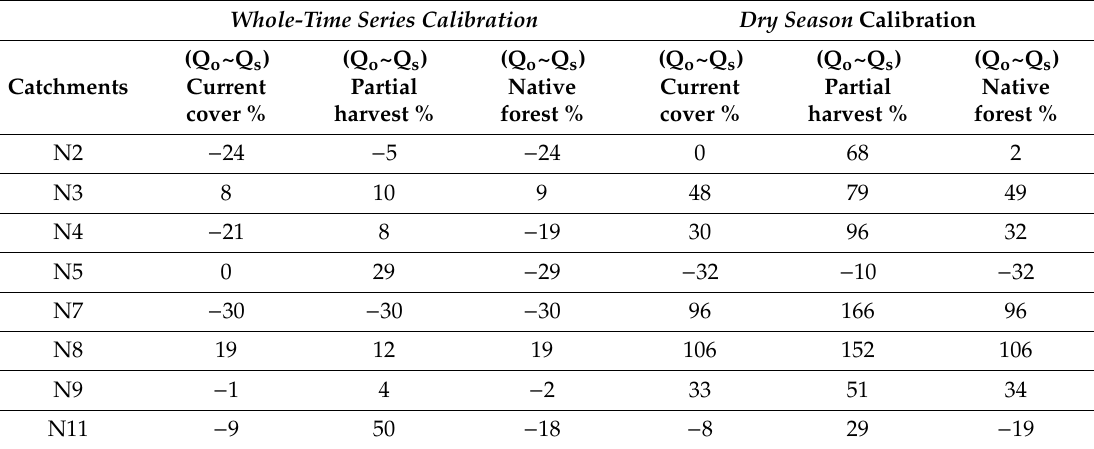
Table 4. Observed (Q o ) and simulated (Q s ) runo ff yield under land use scenarios (% of change) for the two calibration procedures (i.e., Additional supporting information on Table 4 can be found online in the Supporting Information section at the end of the paper, Table